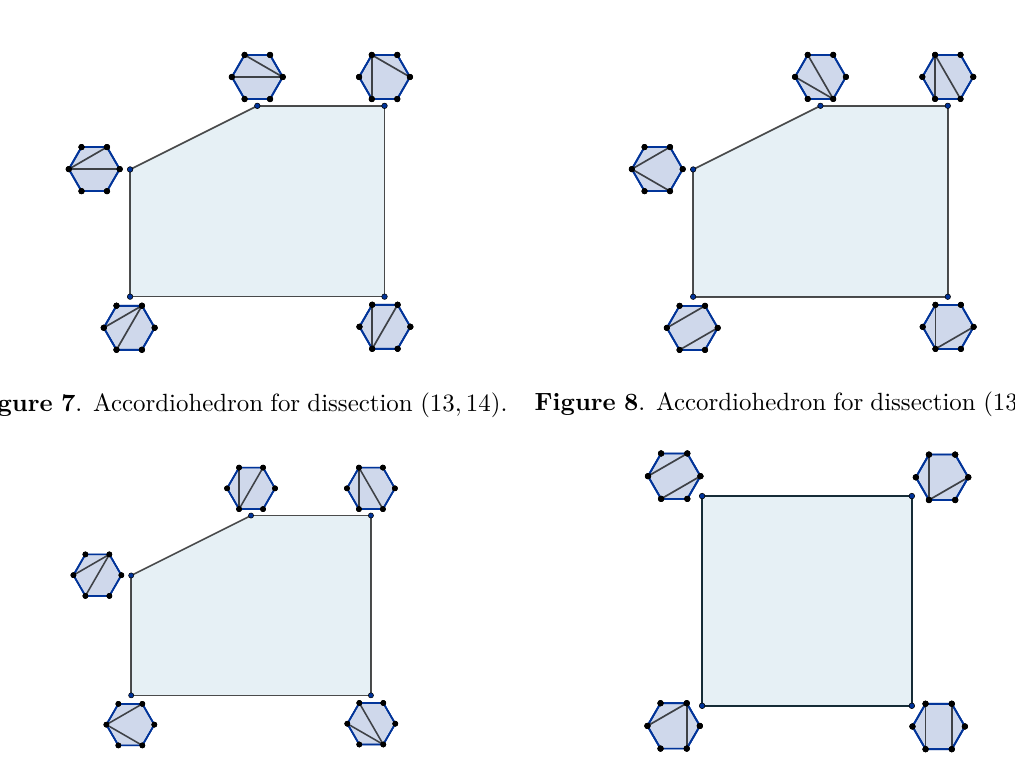
Figure 9 . Accordiohedron for dissection (13 , 36) . Figure 10 . Accordiohedron for dissection (13 , 46)